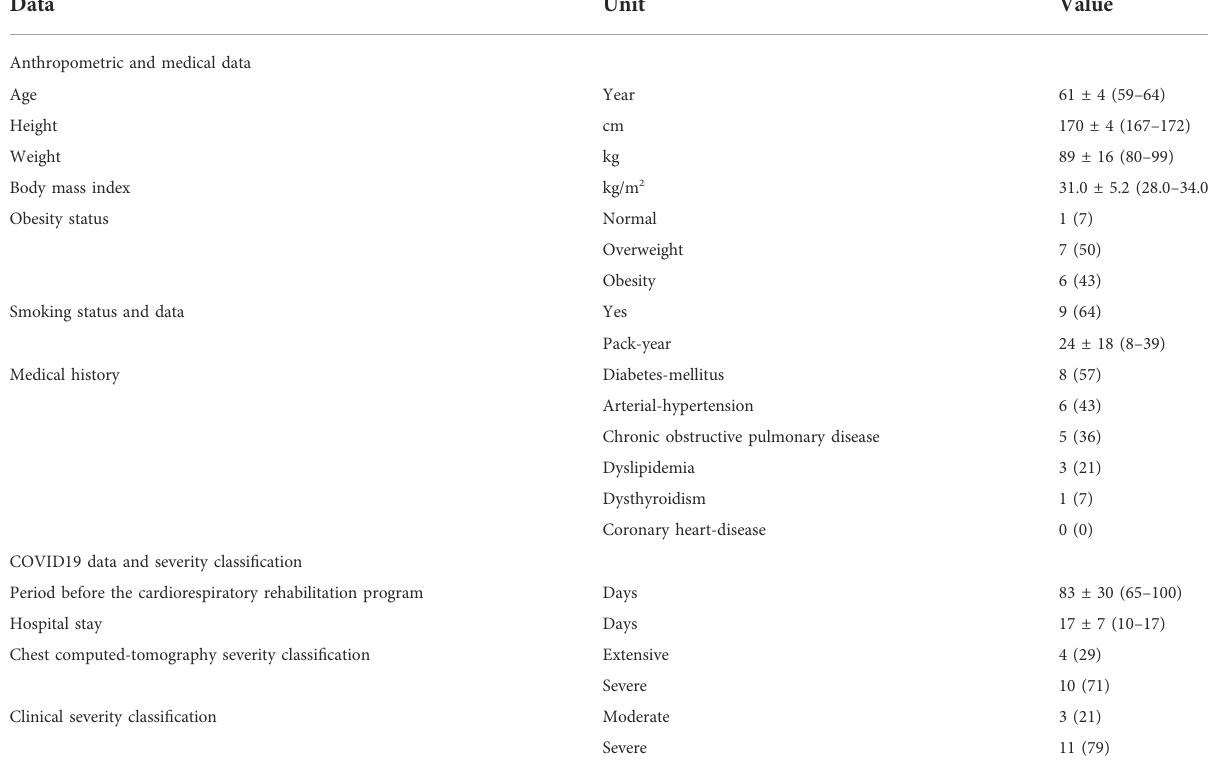
TABLE 1 Initial descriptive data of patients with coronavirus disease 2019 (COVID19) ( n =